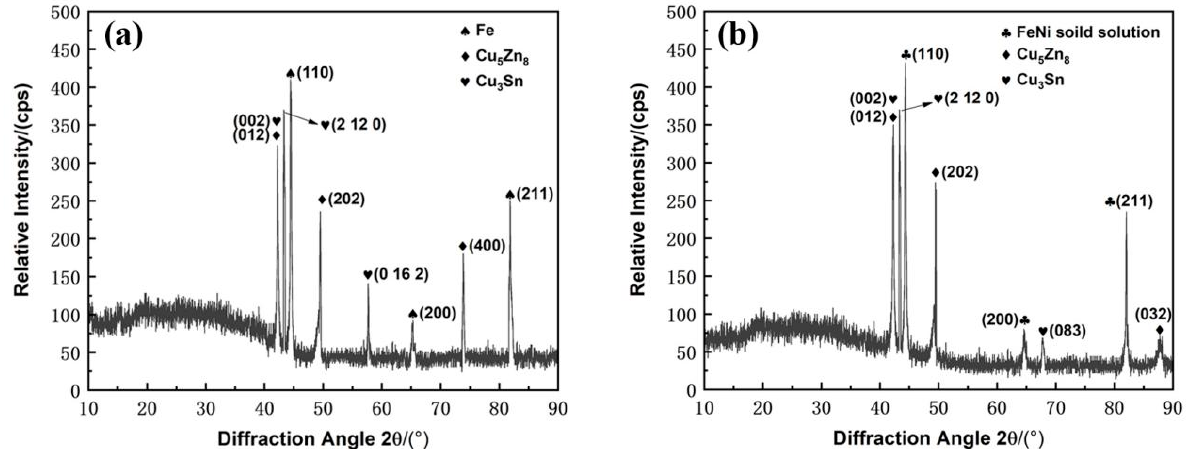
Figure 4. XRD analysis results of the matrix phase: ( a ) Ni-free; ( b ) with 15 wt.% Ni.